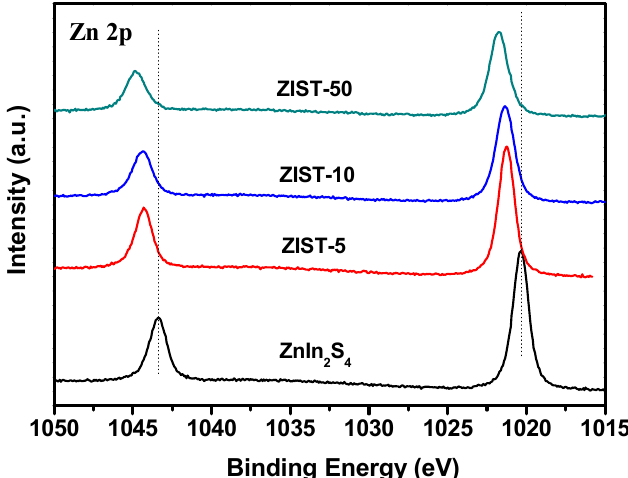
Figure 10. XPS Zn 2p spectra of ZnIn 2 S 4 and ZnIn 2 S 4 /Ti 3 C 2 composites with different Ti 3 C 2 content.